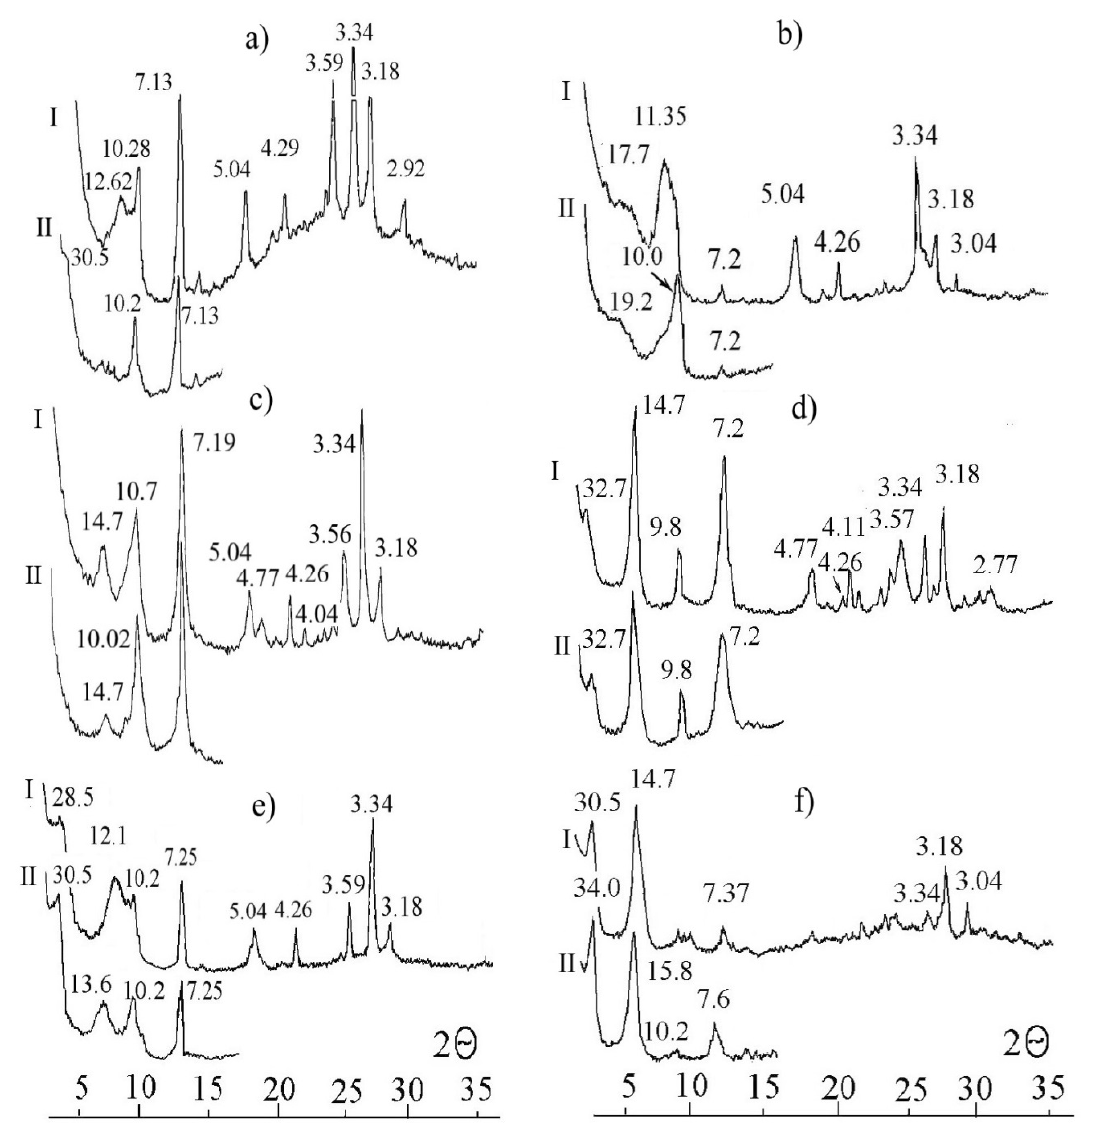
Figure 3. Typical X-ray diffractograms of the cement of Cretaceous rocks of Southern Primorye. Letter designations: ( a ) composition of the mineral association—kaolinite, mica, rectorite, quartz, plagioclase; ( b ) mica, mixed-layer mica–smectite, vermiculite (?), quartz, plagioclase, calcite (?); ( c ) mica, chlorite, quartz, plagioclase; ( d ) corrensite, chlorite, laumontite, quartz, plagioclase; ( e ) rectorite, kaolinite, mica, quartz, plagioclase; ( f ) corrensite, quartz, plagioclase, calcite (?); I—oriented, air-dried; II—ethylene glycol-saturated. Reflections are in angstroms (Å).